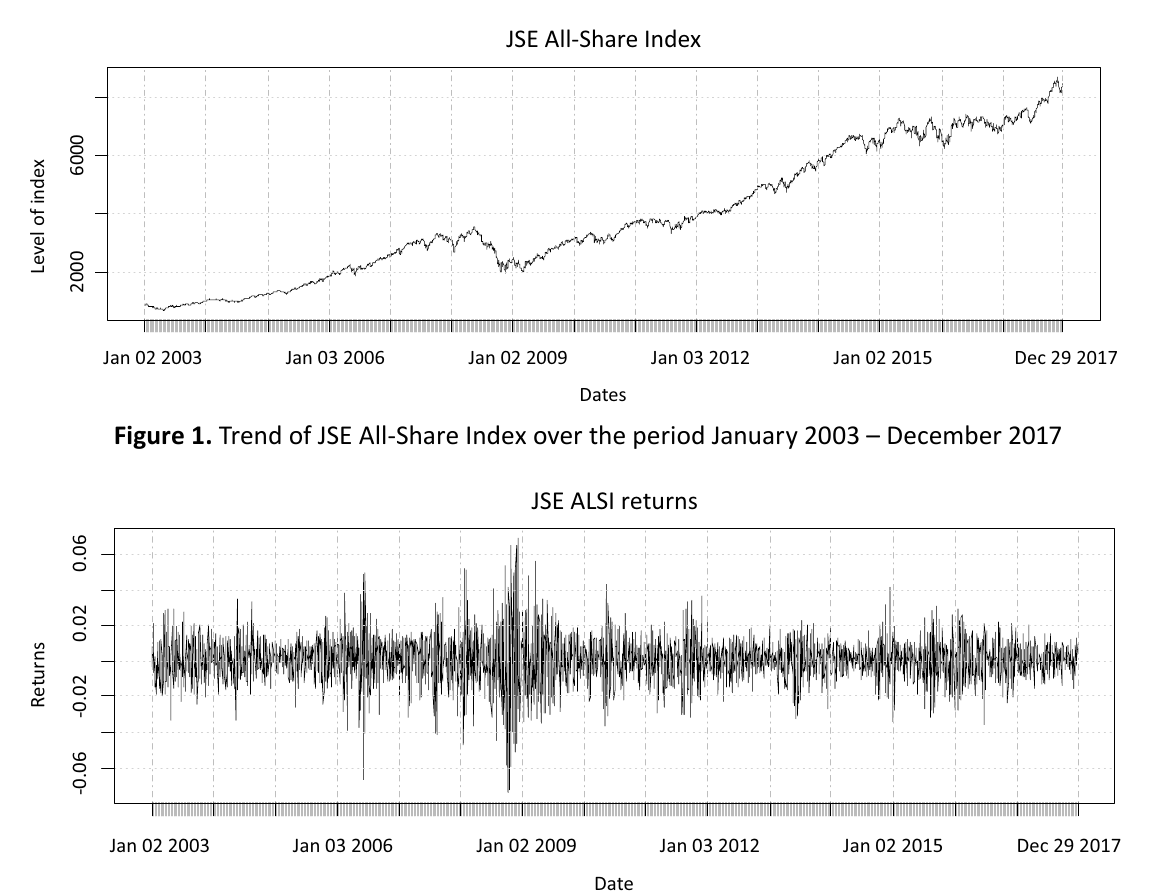
Figure 2. The log returns of JSE All-Share Index over the period January 2003 – December